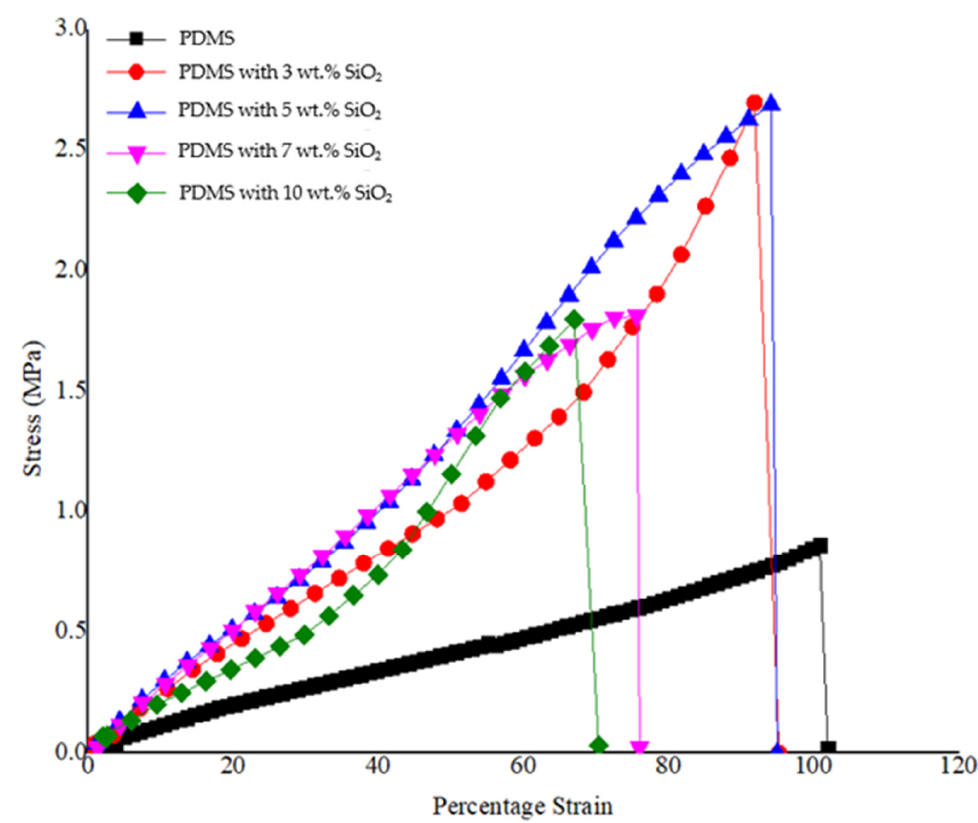
Figure 7. Stress–strain curves of neat PDMS; PDMS with 3, 5, 7 and 10 wt.% SiO 2 (at room tempera- ture).